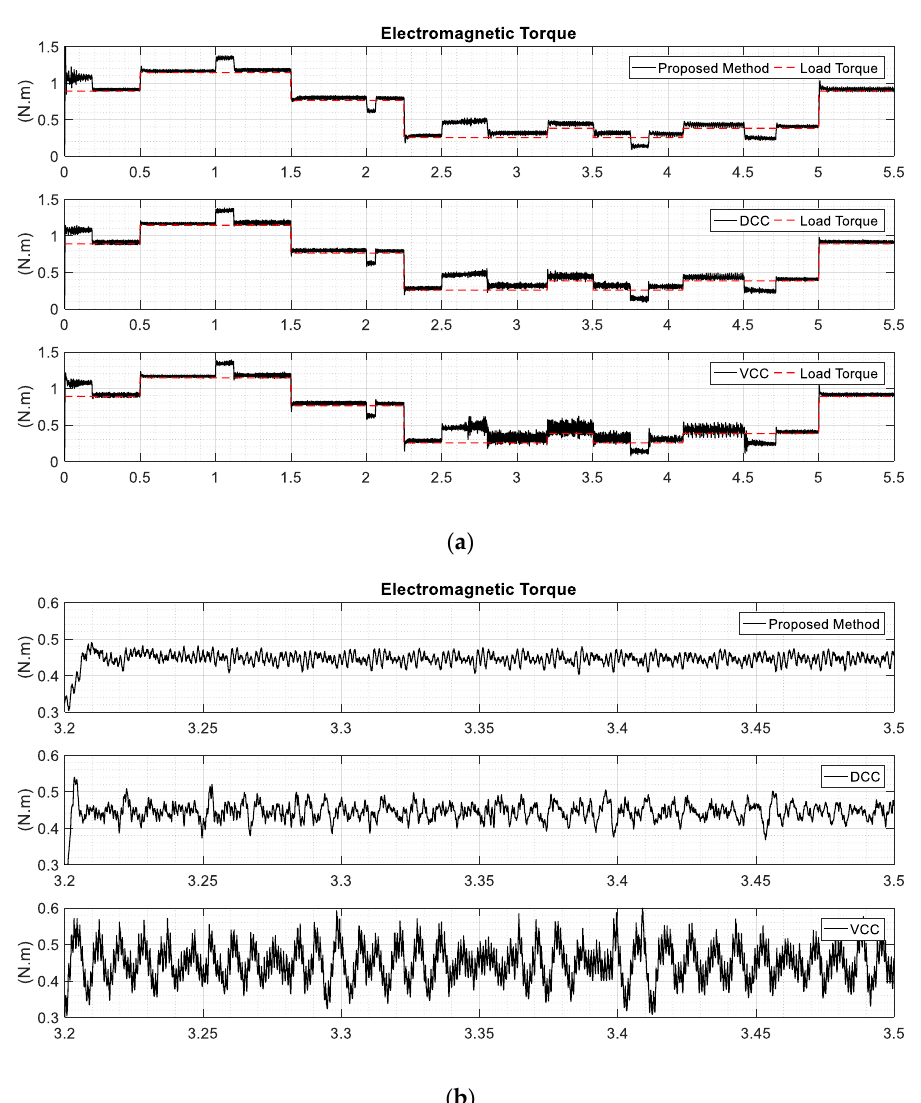
Figure 8. Comparative Electromagnetic Torque results of PMSM in ( a ) full simulation time range and ( b ) interval time of (3.2–3.5 s).